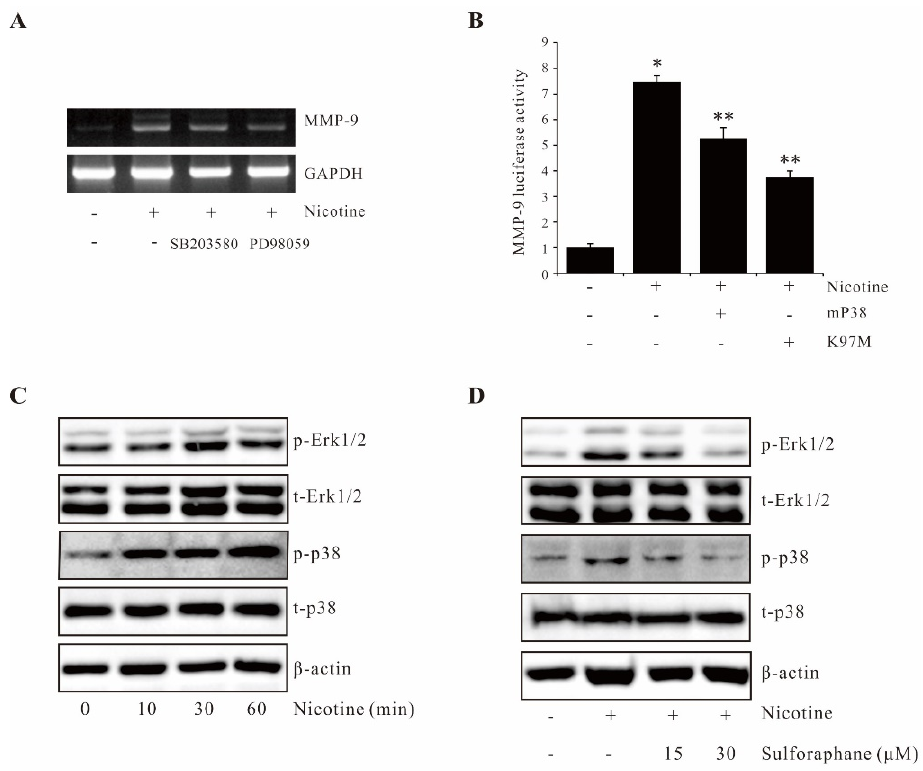
Figure 3. Sulforaphane inhibits nicotine-induced MMP-9 expression by suppressing p38 MAPK and Erk1/2 signaling pathways. ( A ) AGS cells were pretreated with 20 µ M SB203580 and 20 µ M PD 98059 for 1 h and incubated with 100 µ g/mL nicotine for 4 h. After incubation, extracted mRNA was analyzed for the induction of MMP-9 expression by RT-PCR. ( B ) AGS cells were cotransfected with dominant-negative mutants of p38 MAPK (mP38) or MEK-1 (K97M) and the pGL4-MMP-9 promoter-reporter construct. The luciferase activity was determined using a luminometer after incubating the cells with 100 µ g/mL nicotine for 4 h. ( C ) Cells were treated with 100 µ g/mL nicotine for 0–60 min, and extracted proteins were analyzed by Western blot. ( D ) Cells were pretreated with sulforaphane (15, 30 µ M) followed by 100 µ g/mL nicotine treatment for 30 min, and extracted proteins were analyzed by Western blot. The data represent the mean ± SEM from three experimental trials. * p < 0.05 in comparison with the control; ** p < 0.05 in comparison with nicotine